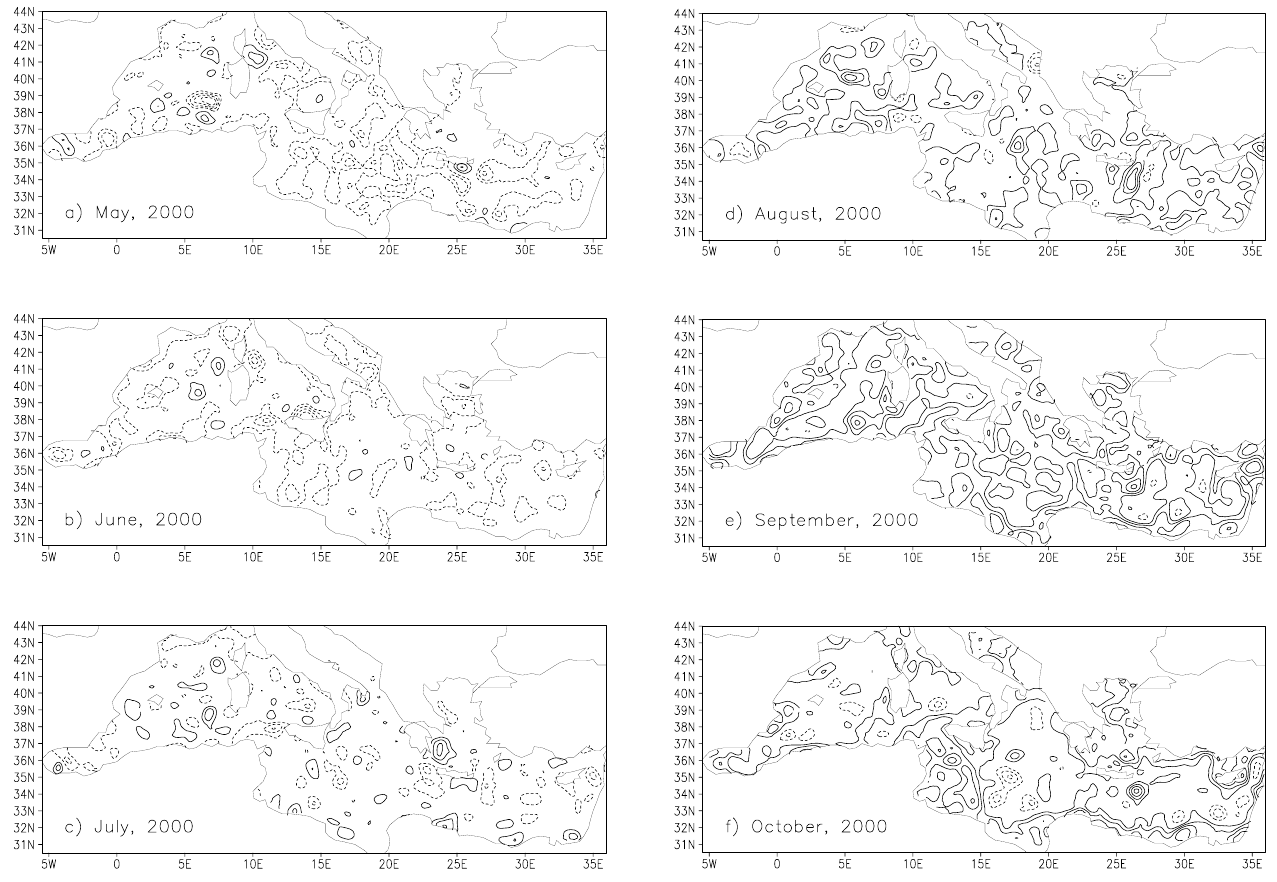
Fig. 7. Difference between monthly mean OA SLA computed only from satellite observations (see the text) and monthly mean of MFSPP SLA analysis for (a) May 2000, (b) June 2000, (c) July 2000, (d) August 2000, (e) September 2000, (f) October 2000. The contour interval is 5cm and the 0 isoline is not